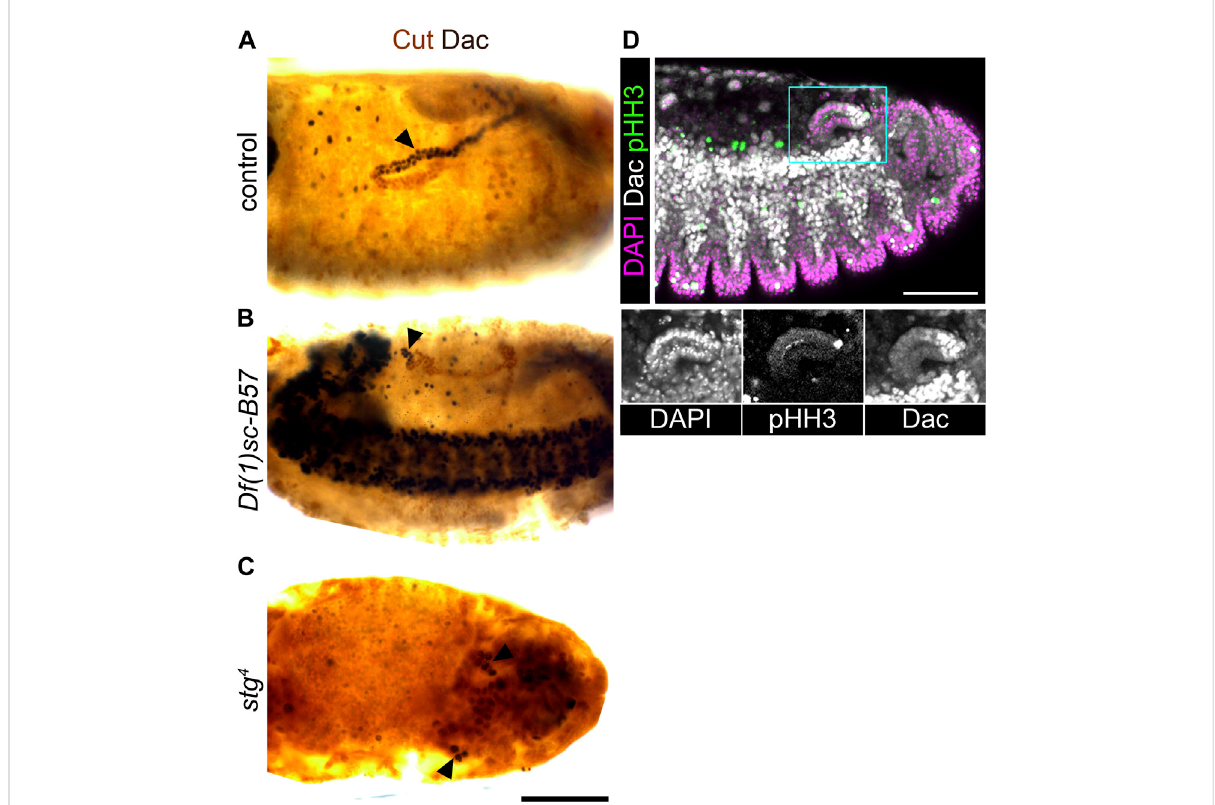
FIGURE 6 Achaete-scute complex genes are not required to specify distal tubule identity, but are required to expand the pool of distal identity cells. (A,B,D) ~Stage 16 embryos stained to show the nuclei of the MpT cells (anti-Cut, brown) and nuclei from the distal MpT cells (anti-Dac, black, arrowheads). (A) Control( w 1118 )embryo. (B) Homozygous Df(1)sc-B57 embryo. (C) Homozygous stg 4 embryo. (D) Wild-type(OrR)embryostainedto show dividing cell nuclei (anti-pHH3) in relation to nuclei of the distal MpT cells (anti-Dac). For tissue context all nuclei are stained with DAPI. Single channel images equate to region in blue box of merged image. Scale bars = 50 μ